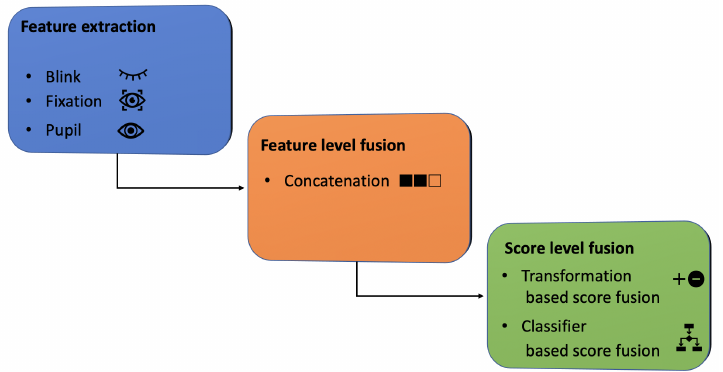
Figure 1. The workflow of the proposed fusion